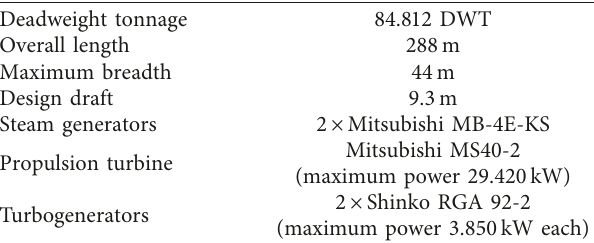
Table 1: Main characteristics of the LNG